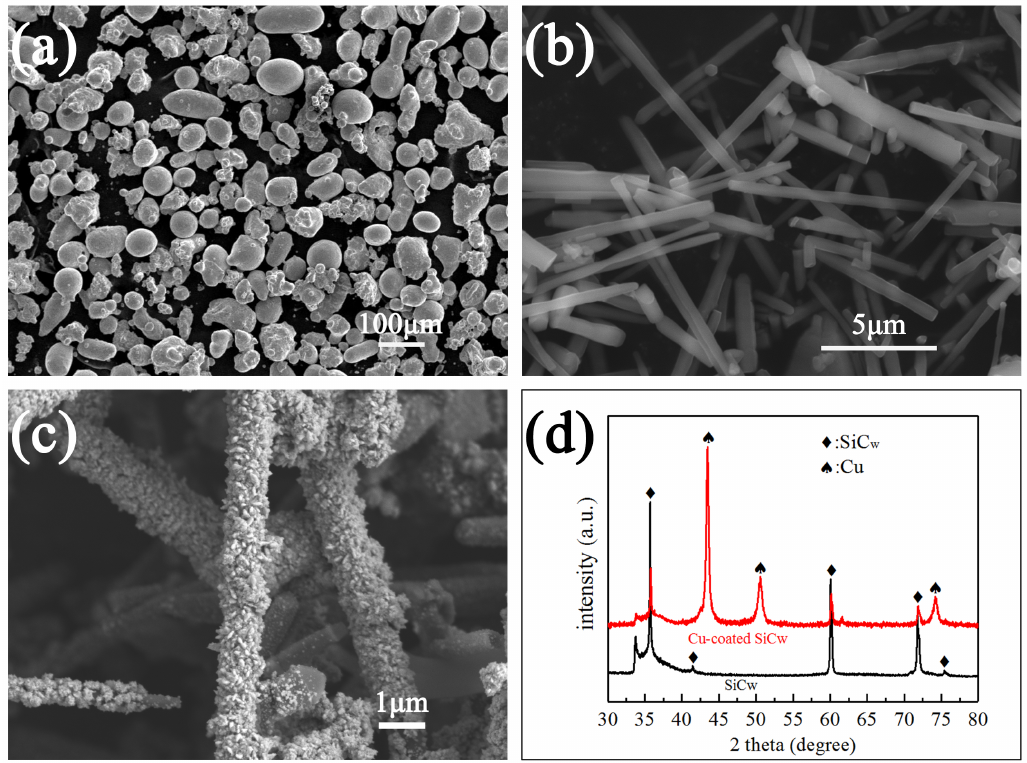
Figure 1: SEM morphology of (a) Cu power, (b) uncoated SiC whiskers, (c) Cu-coated SiC whiskers, (d) XRD diffraction patterns of SiC w coated before and